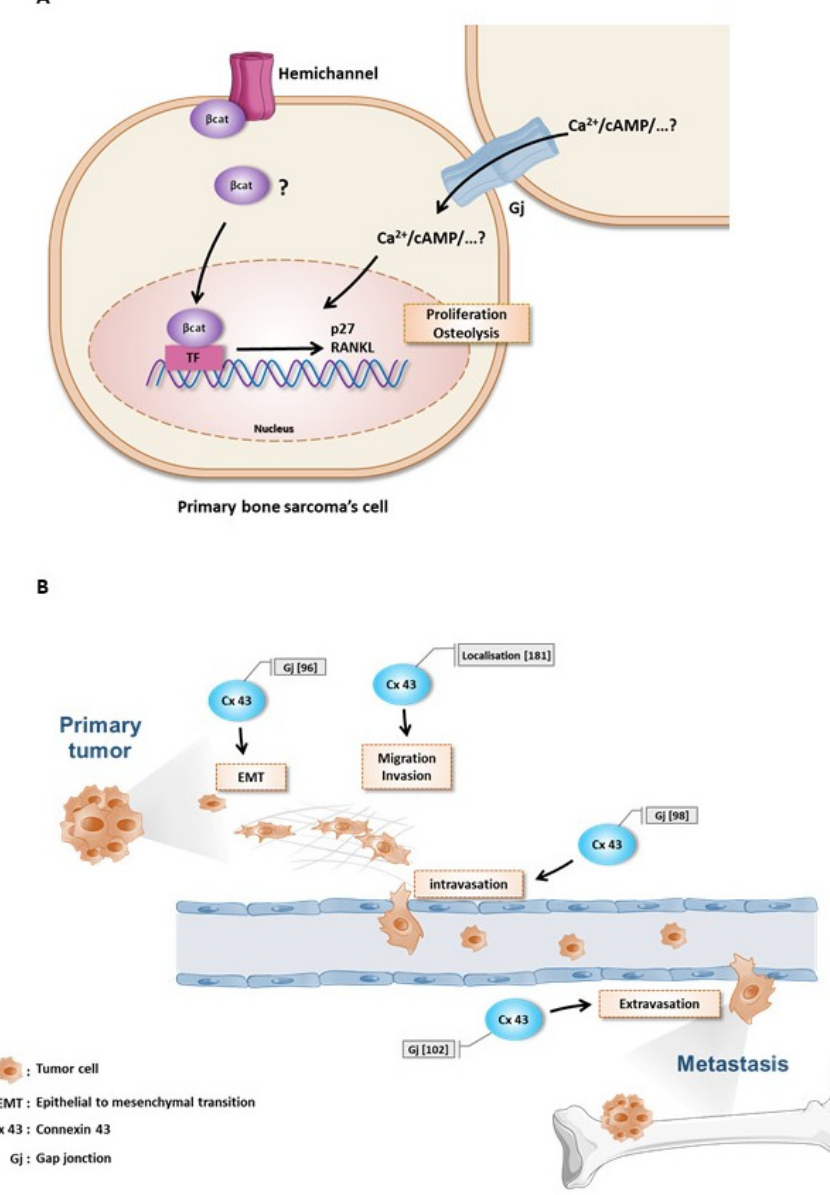
Figure 3. Implication of connexin 43 in ( A ) primary bone tumors and ( B ) secondary bone tumor from prostate